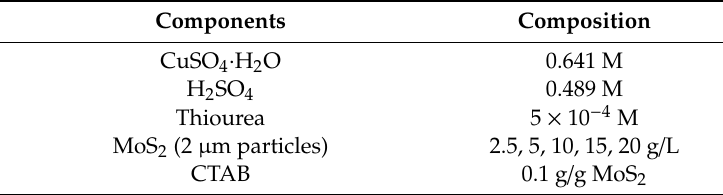
Table 2. Composition of the Cu–MoS 2 electrodeposition solution.